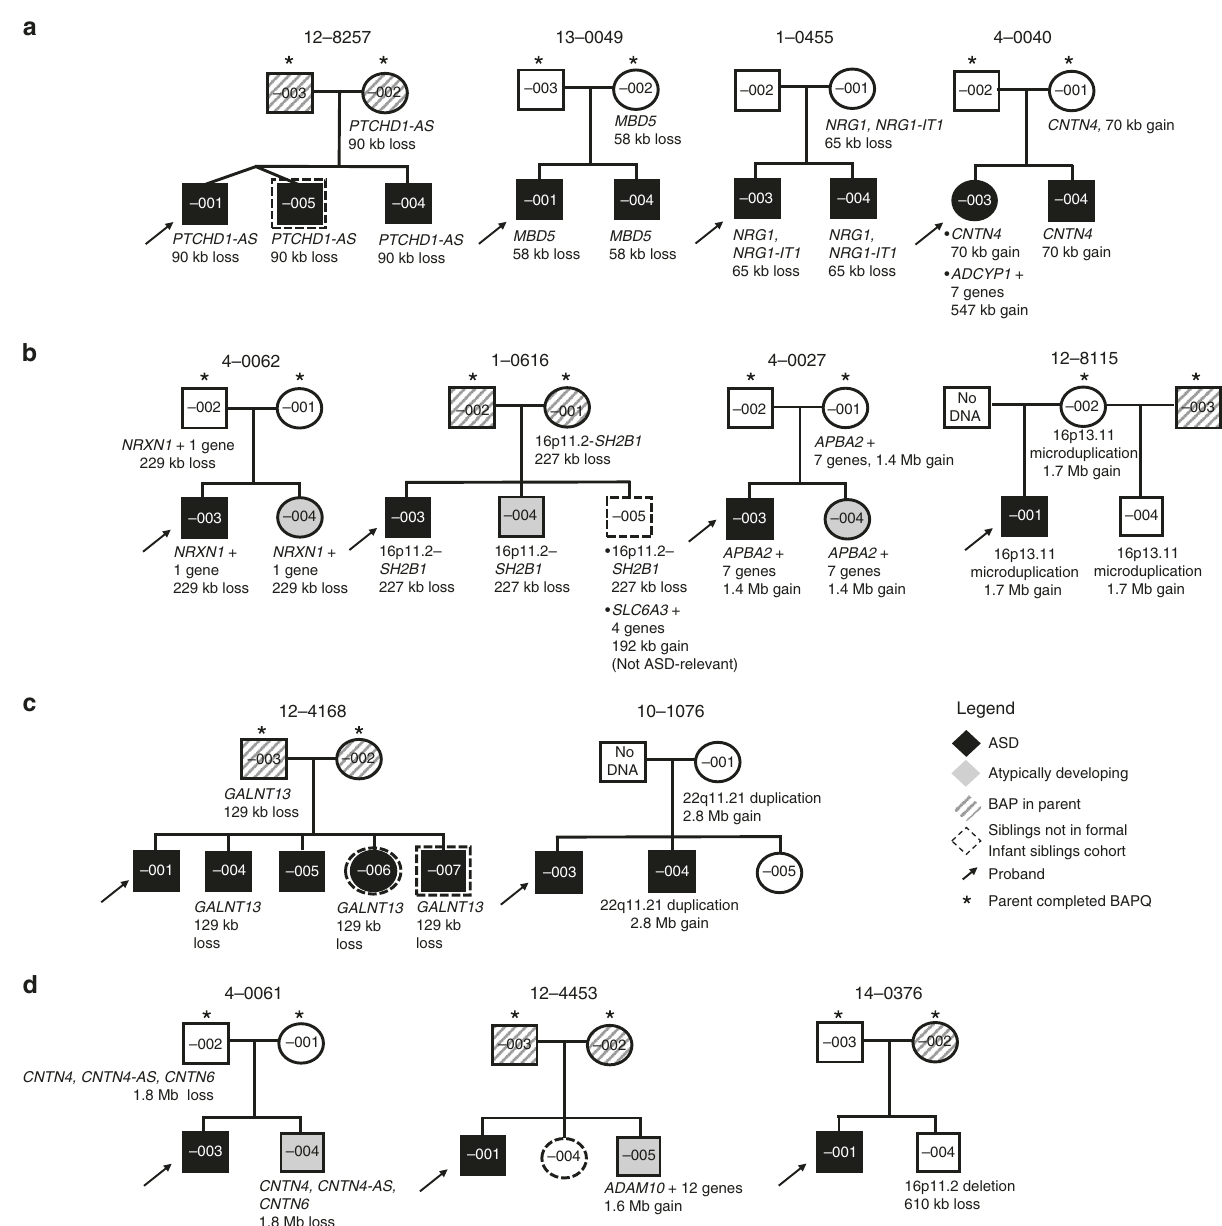
Fig. 3 Pedigrees demonstrating ASD-relevant CNVs in infant siblings. a Infant siblings with ASD who shared a CNV with a related index case (arrow). Targeted testing (only) for a pathogenic CNV was performed on sibling 12-8257-005. b Atypically developing infant siblings who shared a CNV with a related index case. Female sibling 4-0062-004 was positive for ASD on the ADOS (24 and 36 months) assessments, but subthreshold on the ADI-R. Clinical impression was that the child did not have ASD. She had subthreshold scores on the MSEL Early Learning Composite (ELC) (SS = 76) and VABS Adaptive Behavior Composite (ABC) (SS = 84). In family 1-0616, the second-born son (1-0616-004) displayed subthreshold ASD symptoms, vulnerabilities in language and verbal reasoning, gross and fi ne-motor skill delay; the third-born son (1-616-005) (not in the of fi cial cohort) experienced fi ne-motor delay as seen on the VABS at 24 months, and parents reported concerns regarding socialization. In family 4-0027, the female sibling displayed behavioral rigidity and transition dif fi culties. The male sibling in family 12-8115 was developing typically. c Infant siblings with ASD who did not share a CNV with a related index case. d Infant siblings with a CNV not shared with a related index case. Individual 4-0061-004 had language delay and cognitive regression (ELC = 56). Male sibling 12-4453-005 scored just above threshold on the ADOS (CSS = 5), but the clinical history was not consistent with a diagnosis of ASD. His ELC (SS = 88), and ABC (SS = 90) scores were within 1 standard deviation of the expected mean. The scores of male 14-0376-001 on the ADOS (CSS = 1), MSEL (ELC = 91) and the VABS (ABC = 105) re fl ected a typical developmental trajectory. Figure includes 5 additional non-infant siblings who were not counted as part of the formal cohort (dotted outline). CNV classi fi cation is provided in Supplementary Table 4. ASD autism spectrum disorder, CNV copy number variation, ADOS Autism Diagnostic Observation Schedule, CSS calibrated severity score, ADI-R Autism Diagnostic Interview-Revised, MSEL Mullen Scales of Early Learning, VABS Vineland Adaptive Behavior Scales, SS standard